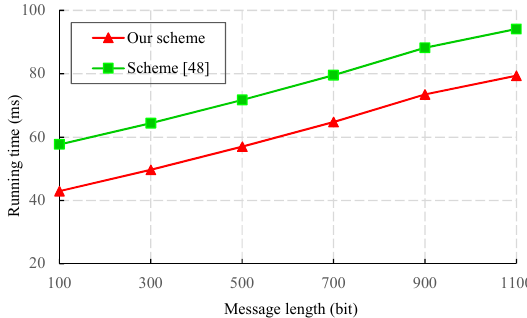
Figure 7. A comparison of the signature generation cost between CLS-based and SDVPRS-based authentication schemes.